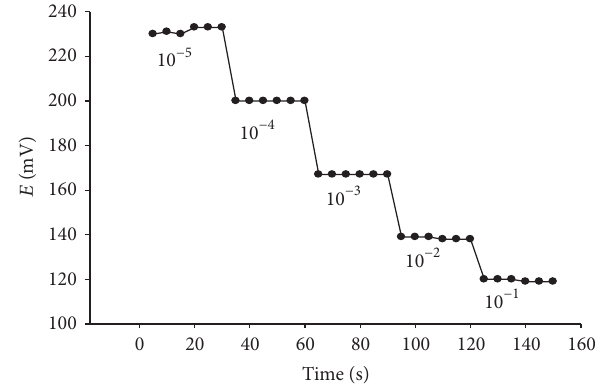
F7:ResponsetimeoftheSMZ-PVCtodifferentconcentration of chromate (pH = 8) in the range of 1